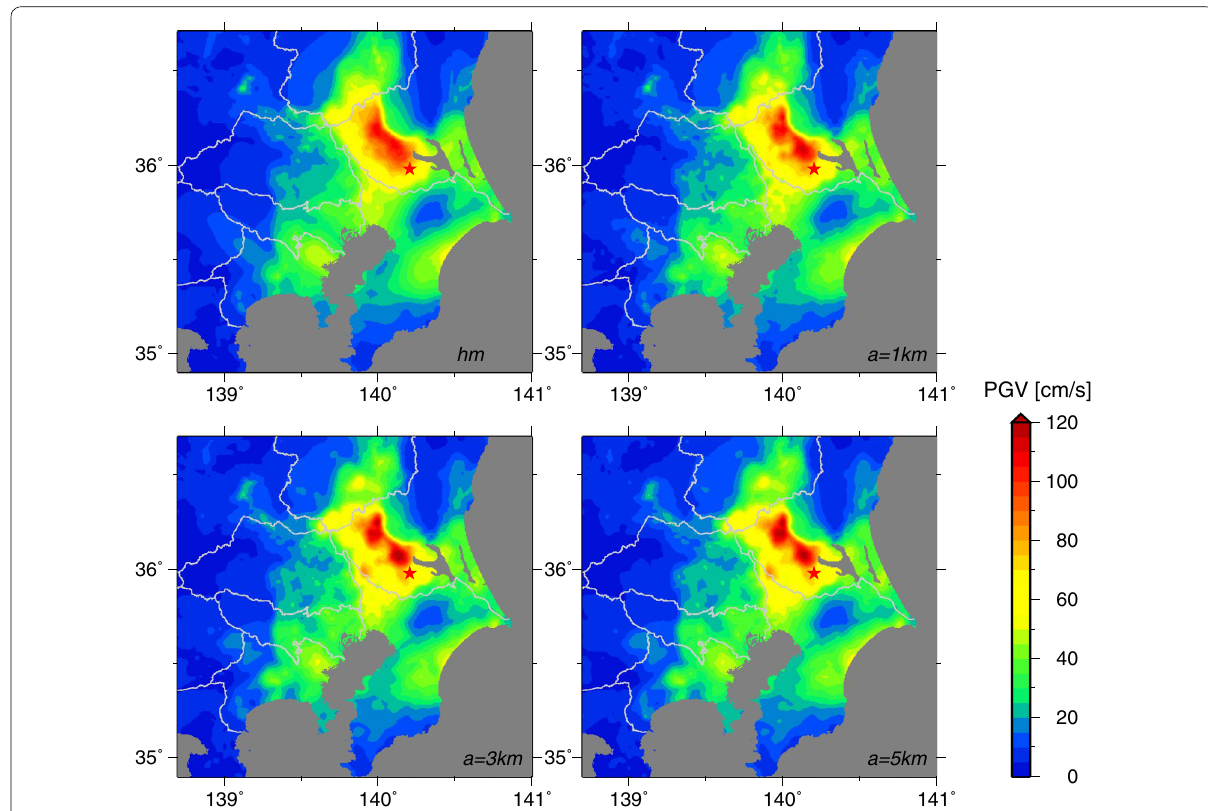
Fig. 5 Simulated peak ground velocity (PGV) of the simulated ground motion. Comparison of PGV for the homogeneous (upper left panel) and the heterogeneous models with a 1, 3, 5 km (upper right, bottom left, and bottom right panels, respectively). Red star denotes the epicenter of the = source model